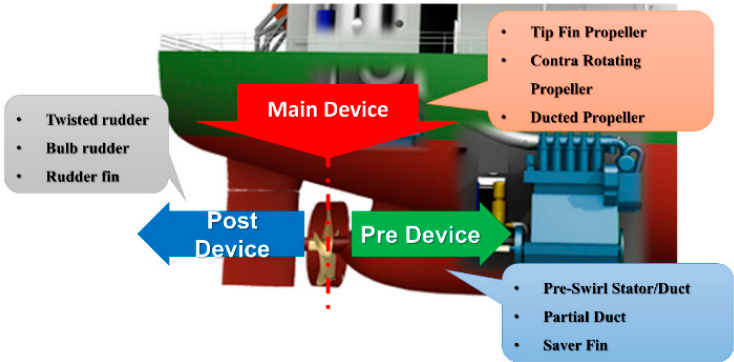
Figure 1. Different types of ESDs used in ships [10].